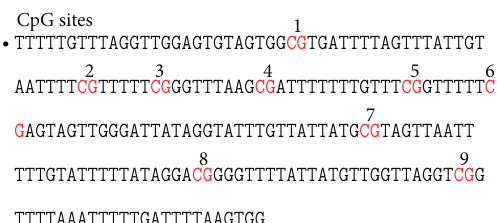
Figure 2: BSP target fragment sequence of PRKCZ gene promoter.